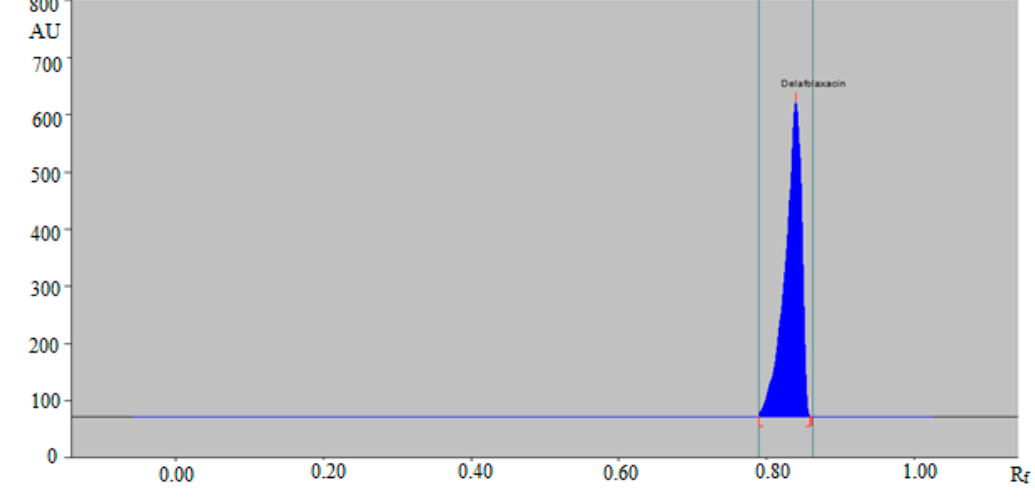
Figure 2. HPTLC chromatogram of standard DLFX by green RP ‐ HPTLC method.